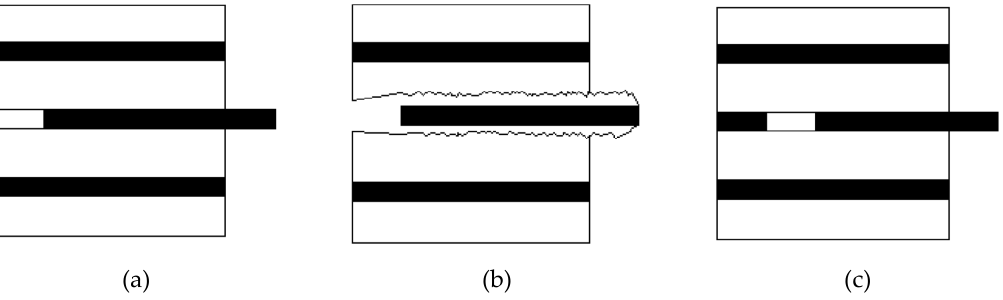
Figure 18. Failure situations: ( a ) fiber slips out from asphalt; ( b ) fiber wrapped with asphalt in the pull-out process; ( c ) fiber breaks in the asphalt.